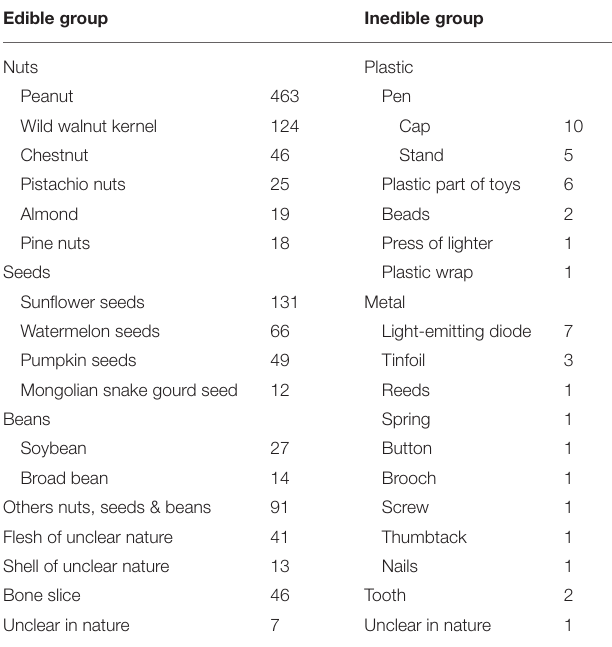
TABLE 4 | Type of foreign bodies in the airway between the edible foreign body group and the inedible group. Edible group Inedible